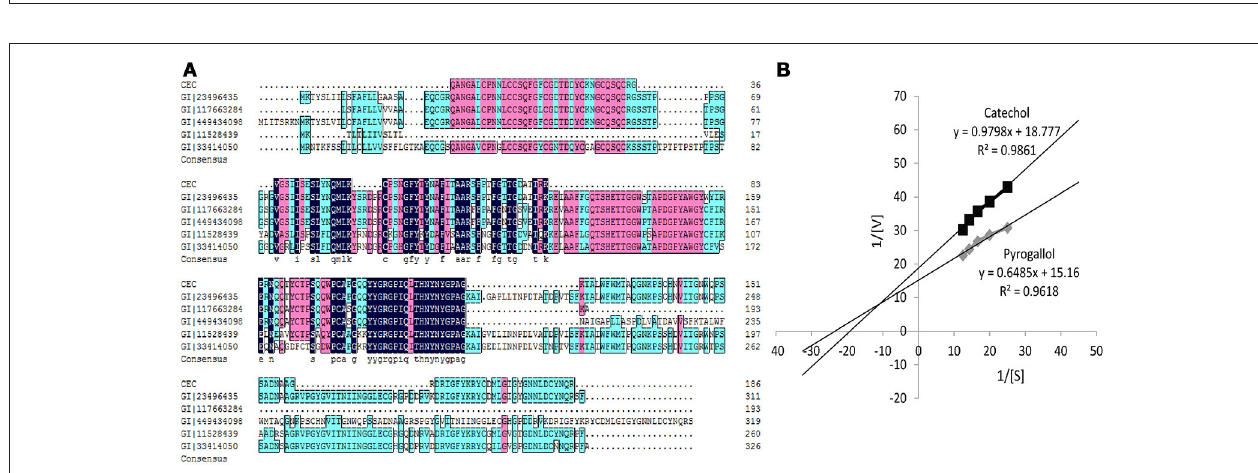
FIGURE 1 | (A) Proteins of eluted profiles from DEAE Sepharose fast flow column. (B) Profiles of BRP eluted from Sephacryl S200 column. (C) Electrophoresis behavior of BRP. Lane a, SDS-PAGE of BRP stained by Coomassie Brilliant Blue R-250. Lane b, Native-PAGE of BRP stained by Coomassie Brilliant Blue R-250. Lane c, Native-PAGE of BRP stained by pyrogallol. Lane M, Prestained protein ladder.